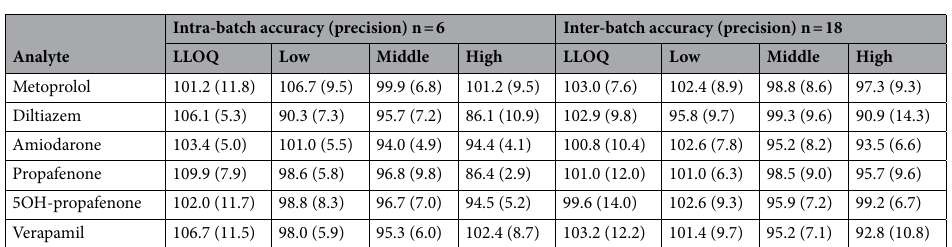
Table 4. Accuracy and precision of anti-arrhythmic compounds in human serum.